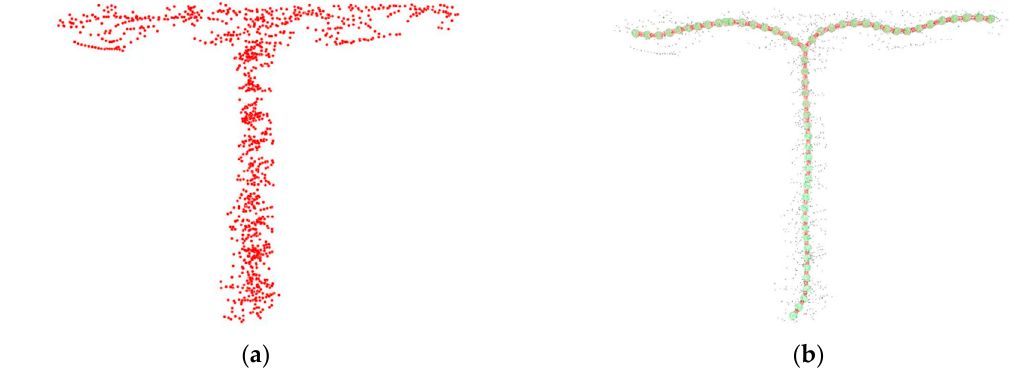
Figure 10. ( a ) An MMS point cloud imported in the L 1 -medial skeleton viewer. ( b ) Skeleton results (grey points are the input point cloud, green points are the nodes, and red lines are segments).